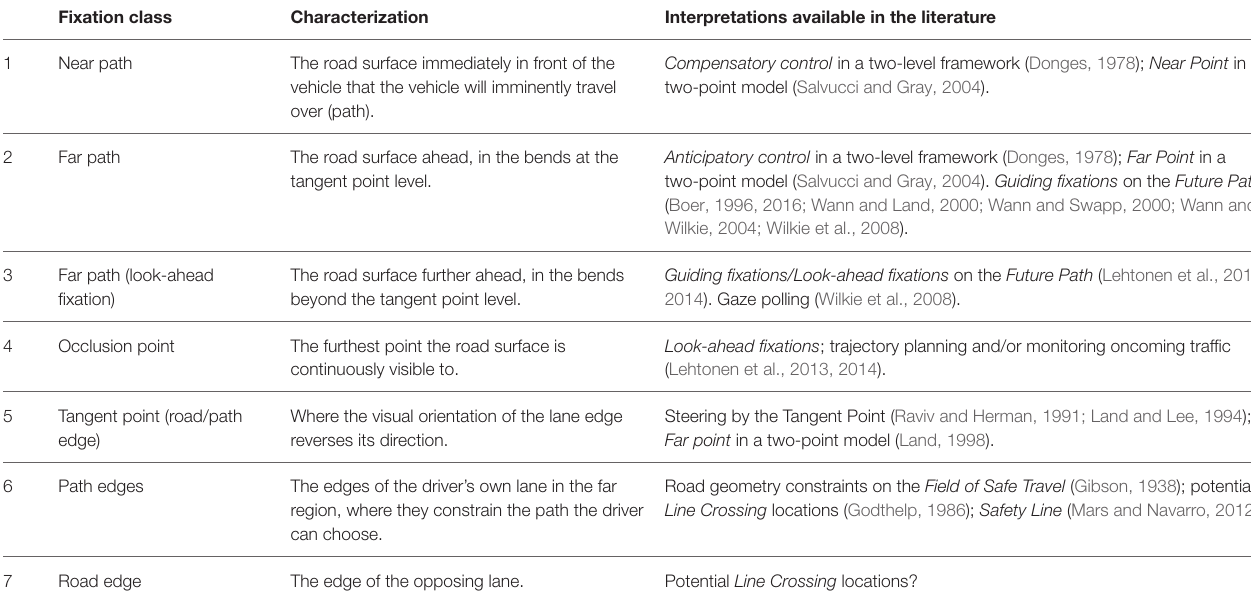
TABLE 3 | Labeling used, and interpretations found in the literature, for fixations in the Far road. Fixation